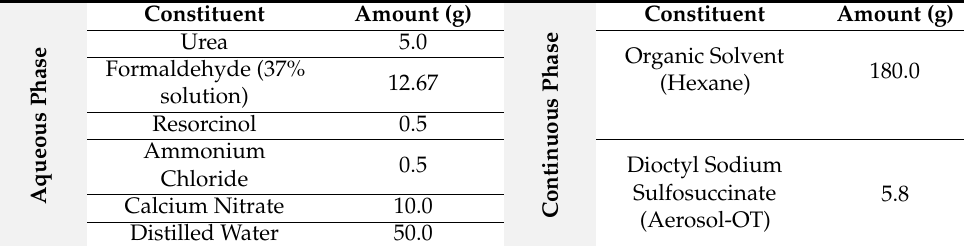
Table 1. Modified synthesis of aqueous and continuous